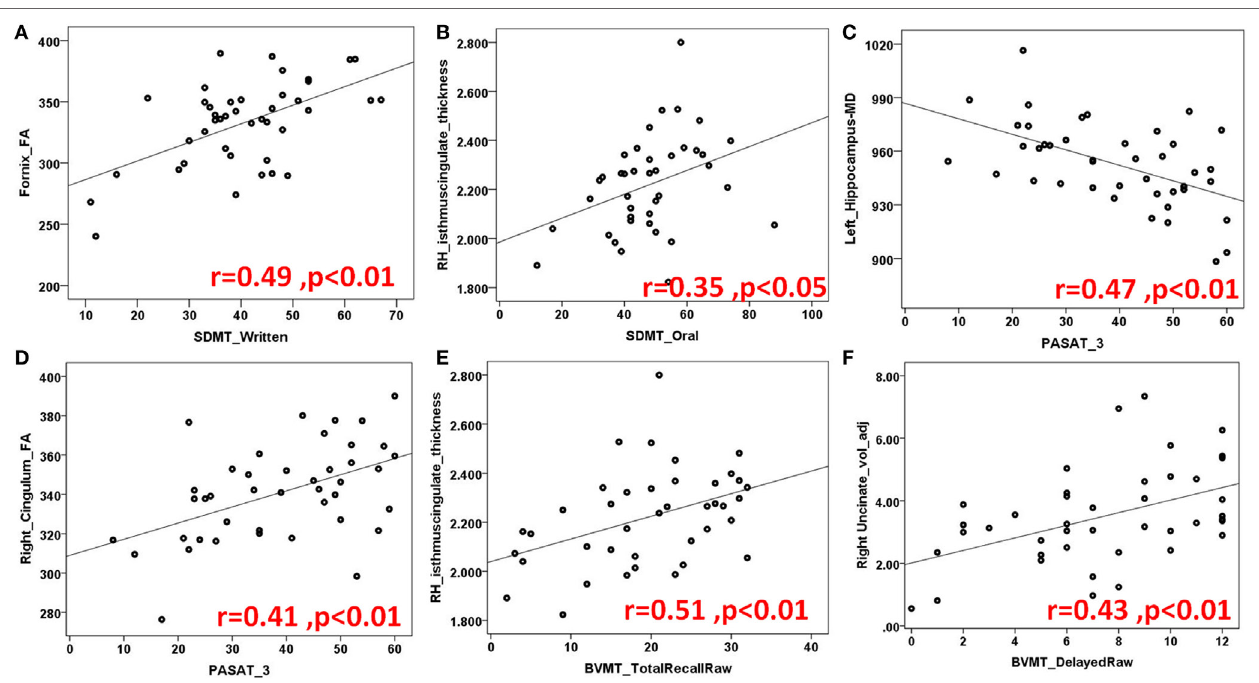
FigUre 4 | Another demonstration of several scatter plots of limbic structures and Symbol Digit Modality Test (SDMT) (a,B) written and oral versions, Paced auditory serial addition test (PASAT) (c,D) , Brief visuospatial memory test (BVMT) total (e) and delayed recall (F) sets. Abbreviations: FA, fractional anisotropy; MD, mean diffusivity; RH, right hemisphere; voladj, volume adjusted for intracranial